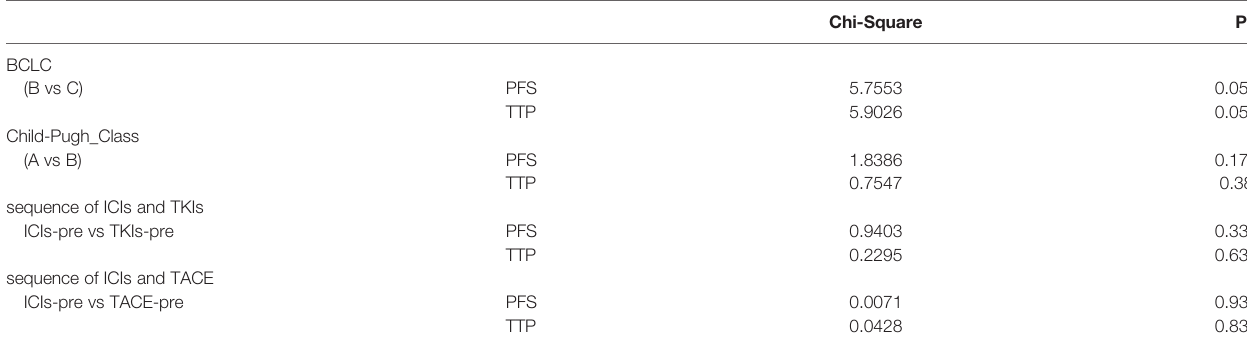
TABLE 4 | Subgroup analysis of clinical ef fi